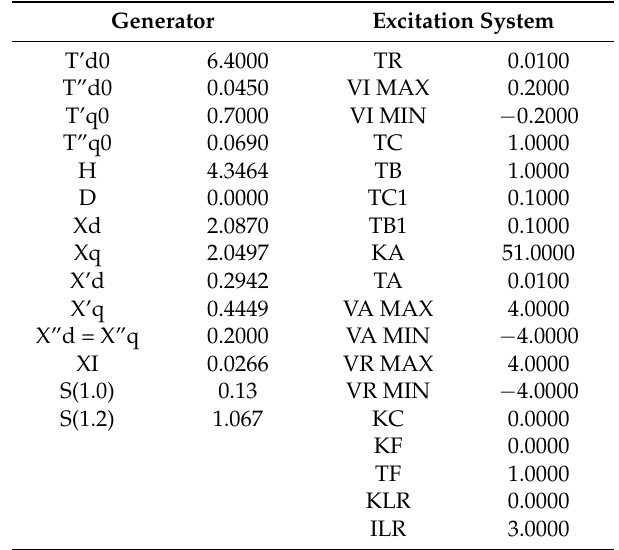
Table A1. Dynamic parameters of the sending-end generator and the excitation